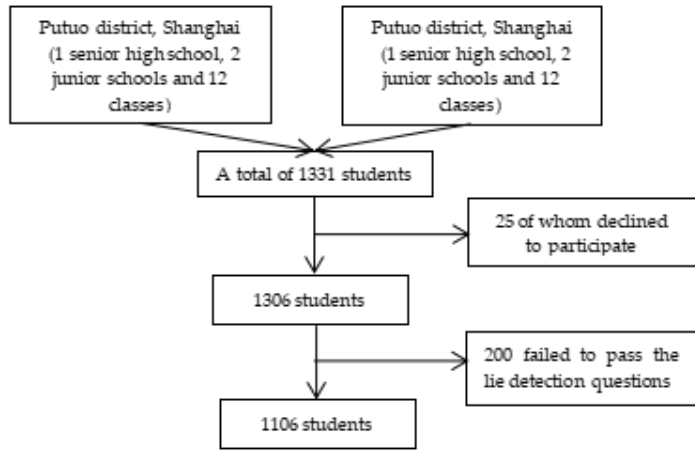
Figure 1. Sampling Figure 1. Sampling frame.